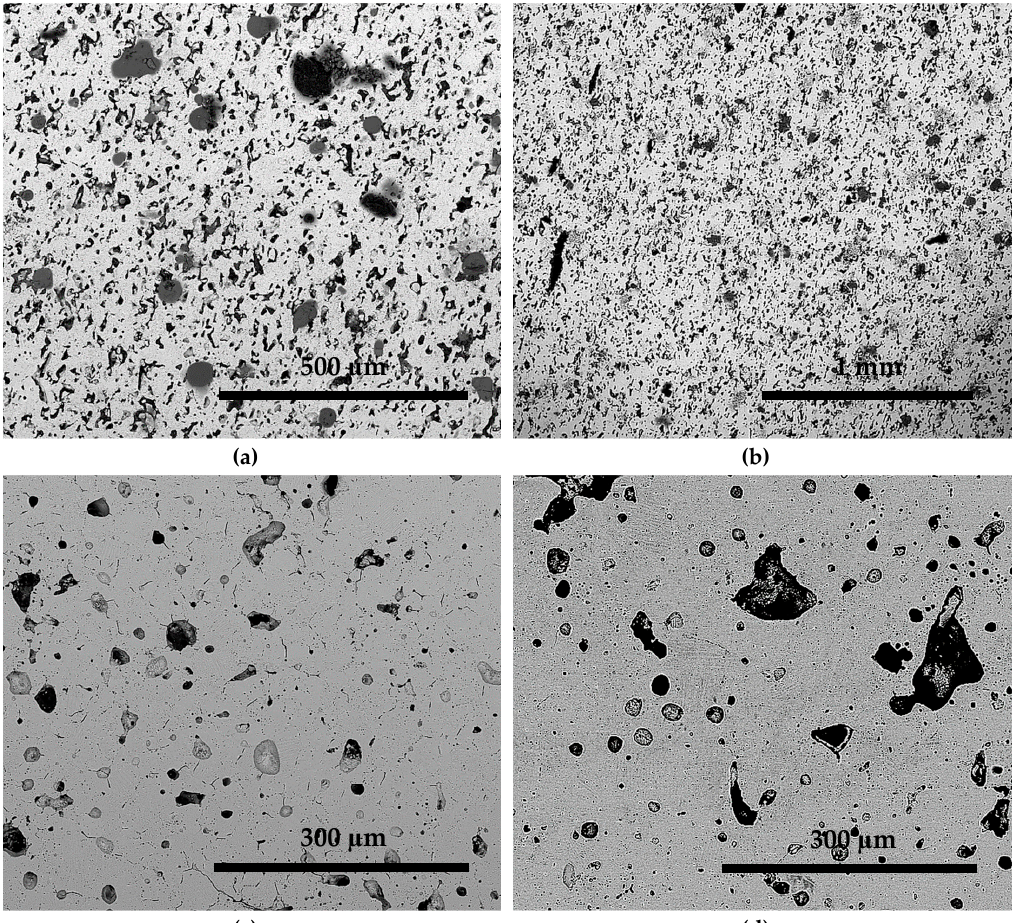
Figure 4. BSE images of samples: ( a ) S950a2; ( b ) S950b2; ( c ) S1050a2; and ( d ) S1050b2.